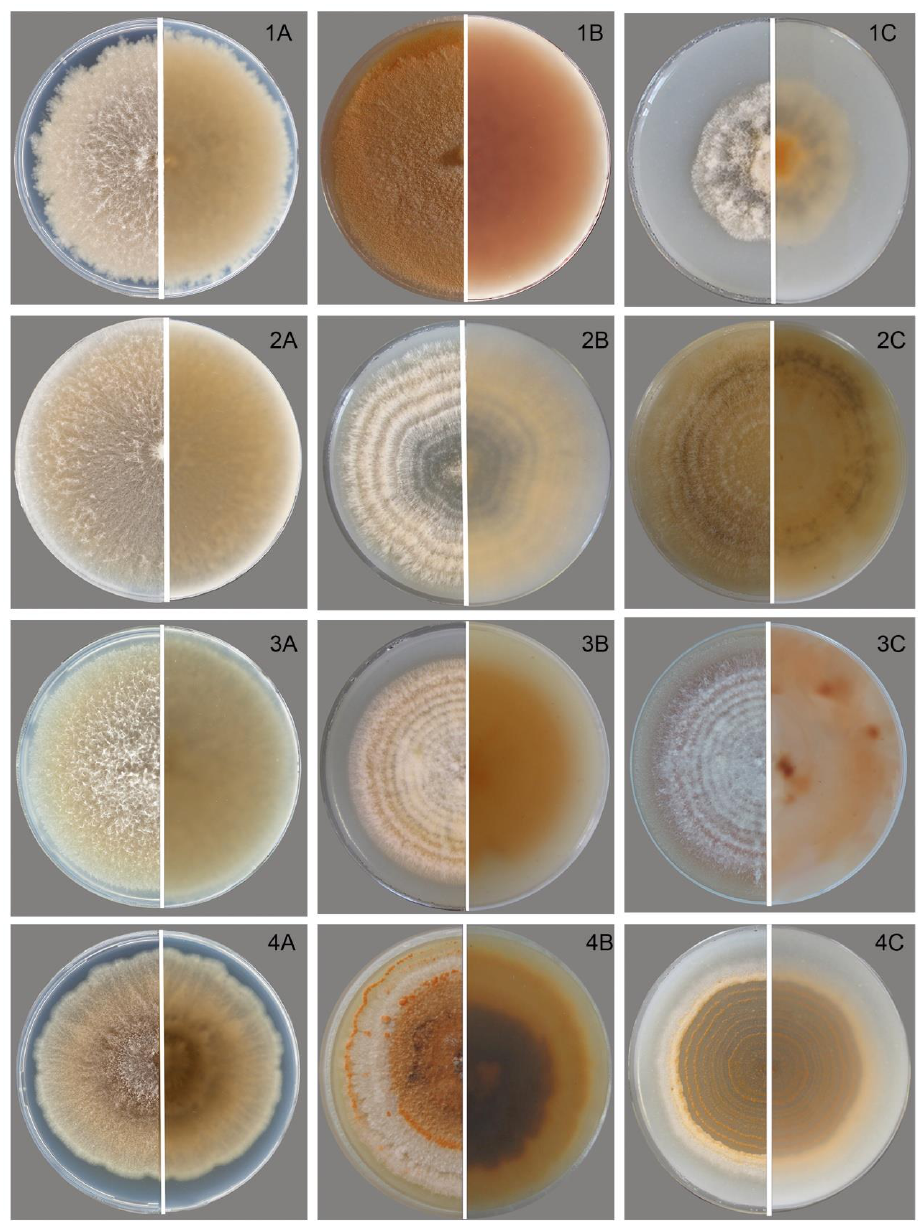
Figure 2. Cultures of Microdochium fungi in a 80 mm Petri dishes at 25 °C. M. majus : (1 A ) on PSA in dark, two weeks; (1 B ) on PSA under UF, two weeks; (1 C ) and on OA, 16/8 light and dark, one week. M. nivale : (2 A ) on PSA in dark, two weeks; (2 B ) on OA 16/8 light and dark, one week; (2 C ) and on OA, 16/8 light and dark, four weeks. M. seminicola : (3 A ) strain on PSA in dark, two weeks; (3 B ) on OA, 16/8 light and dark, one week; (3 C ) and on OA, 16/8 light and dark, two weeks. Microdochium sp. strain MFG58962: (4 A ) on PSA in dark, two weeks; (4 B ) on PSA, light, four weeks; and (4 C ) on OA, 16/8 light and dark, one week.